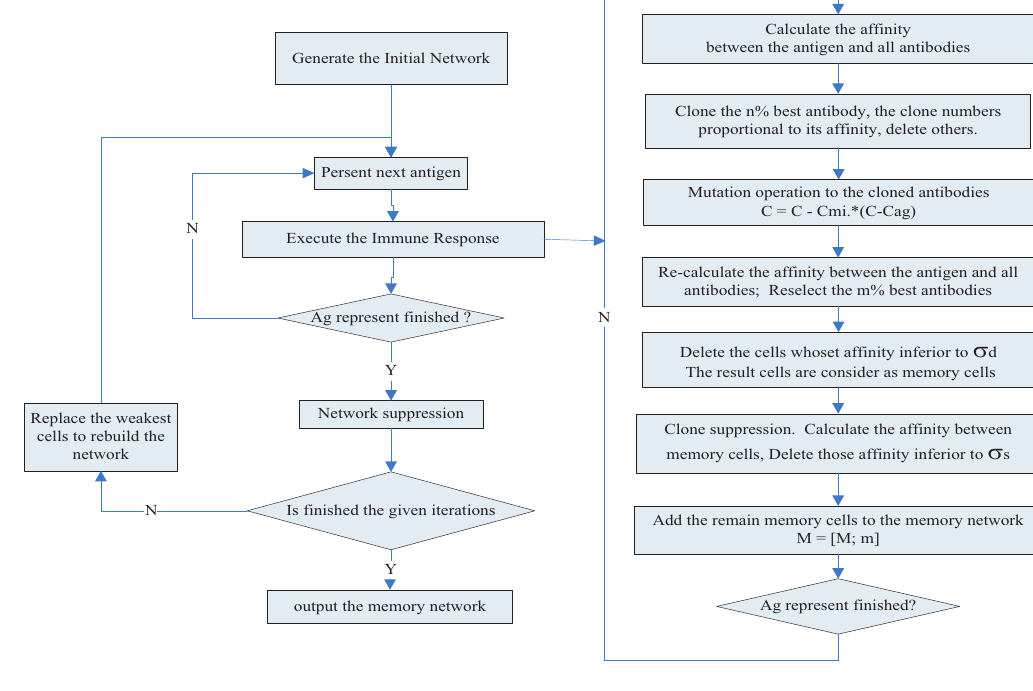
Fig. 1. Artificial Immune Network algorithm detail